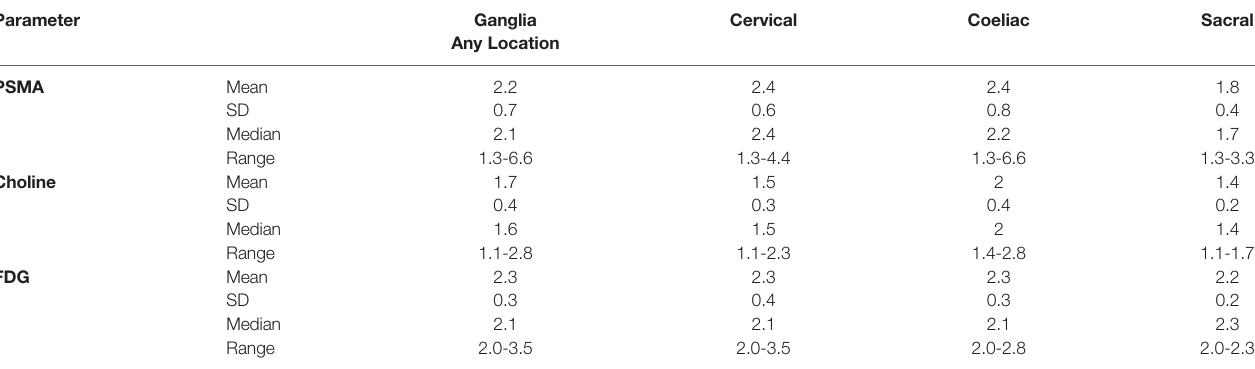
LNM was found at a frequency of 5.0% (6/120) of patients, 6.7% (8/120) of patients, and 25.0% (30/120) of patients near the typical location of cervical, coeliac, and sacral ganglia, respectively. Frequencies in the occurrence of FDG-positive ganglia and LNM were signi fi cantly different at each location (P < 0.001). FDG uptake in LNM was signi fi cantly higher than in ganglia cervical, coeliac, and sacral locations (any location: 4.9 ± 2.2 ± 0.3, P < 0.001) ( Figure 4C ). ROC Curve Analysis to Differentiate Ganglia From LNM The optimal SUVmax threshold of PSMA-PET, choline-PET or FDG-PET for distinguishing between LNM and ganglia is shown in Figure 5 . Receiver-operating characteristic (ROC) curve analysis revealed that at when the SUVmax cutoff of PSMA-